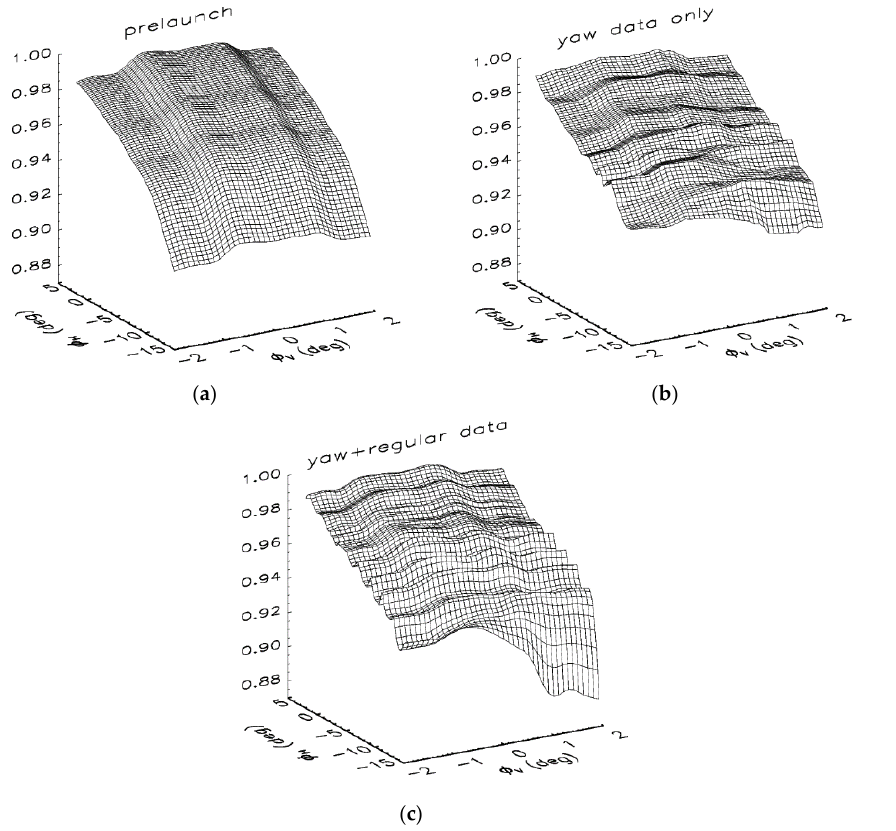
Figure 8. Plots of the relative transmittance of the SDSM screen for D8 using prelaunch data ( a ); yaw maneuver data ( b ) and yaw maneuver and a small portion of regular on-orbit data ( c ).